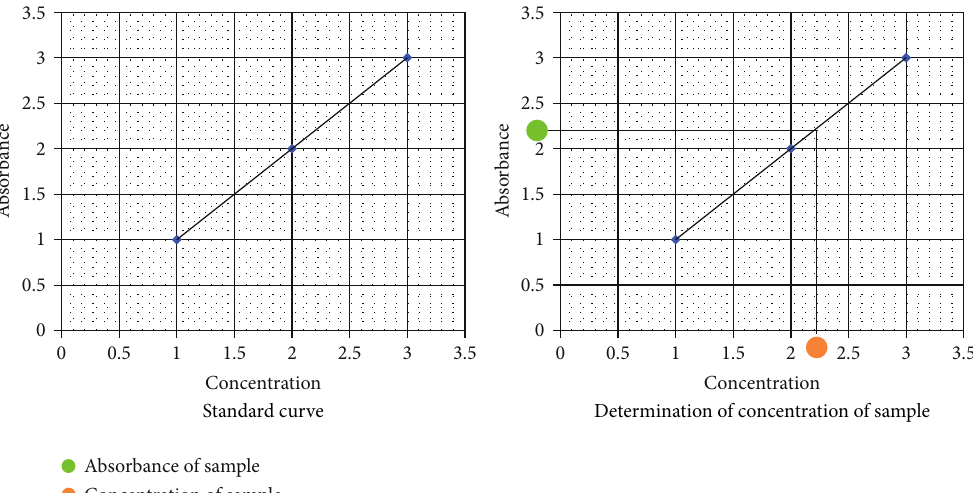
Figure 1: Curve of the concentration and absorbance.